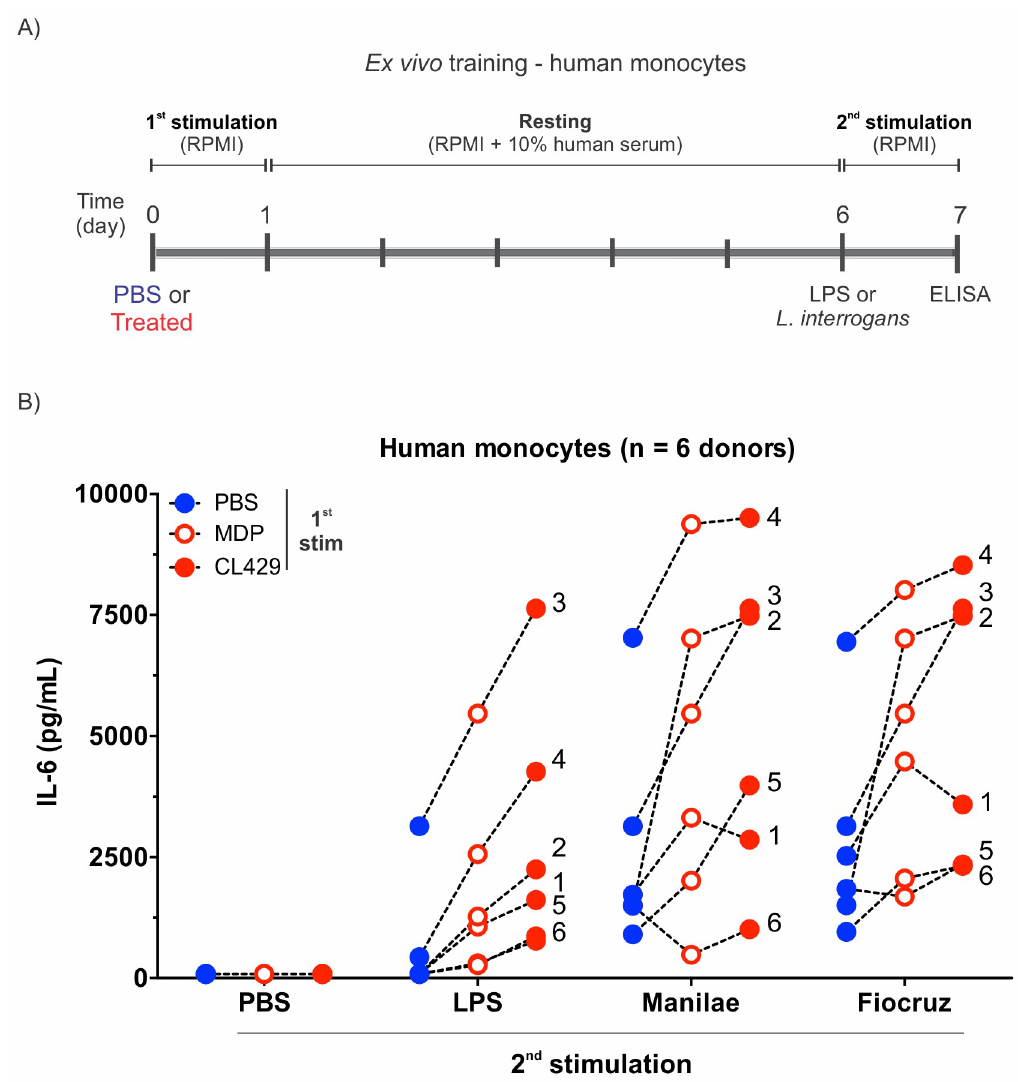
Fig 7. Training of human primary monocytes with CL429 enhances the IL-6 pro-inflammatory cytokine response. A) Chronogram of in vitro training of human monocytes isolated from healthy human blood. B) Comparative IL-6 profiles for n = 6 individual donors (performed in 3 independent experiments) following different initial stimulations with PBS, MDP or CL429 each at 0.1 μ M. The second stimulation was performed with PBS as a control, LPS (100 ng/mL) or live leptospires (serovars Manilae and Fiocruz) at MOI of 100. Each number corresponds to an individual donor. Each dot represents a training condition for a particular donor, and the graphed value corresponds to the average of 4 technical replicates.